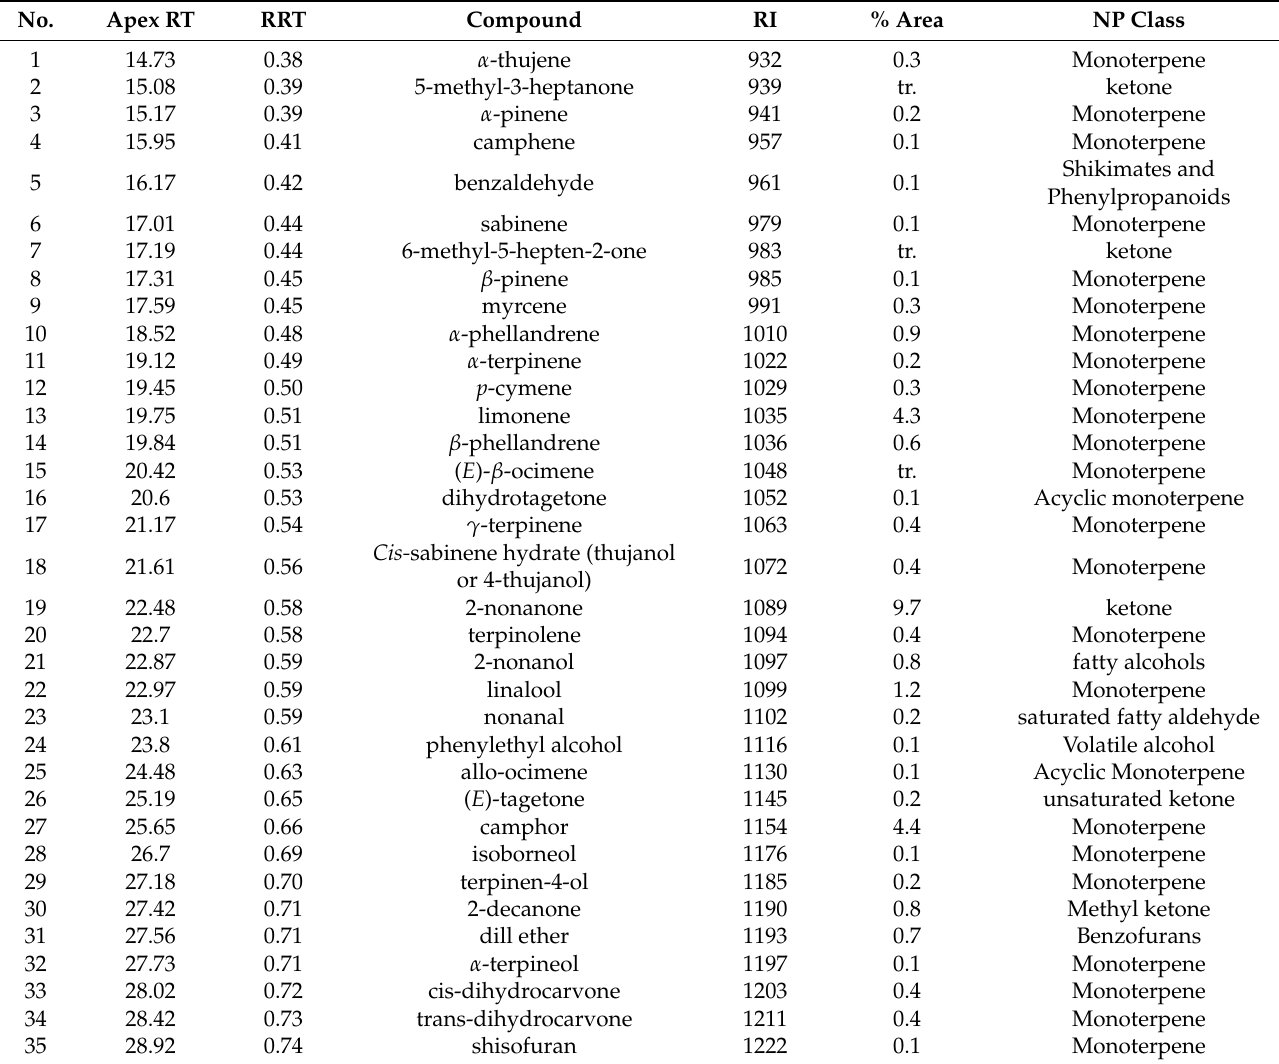
Figure 2. Total ion chromatogram (TIC) for GC/MS of T. patula flowers volatile constituents. Table 1. Phytochemical compositions of T. patula flowers volatile constituents.